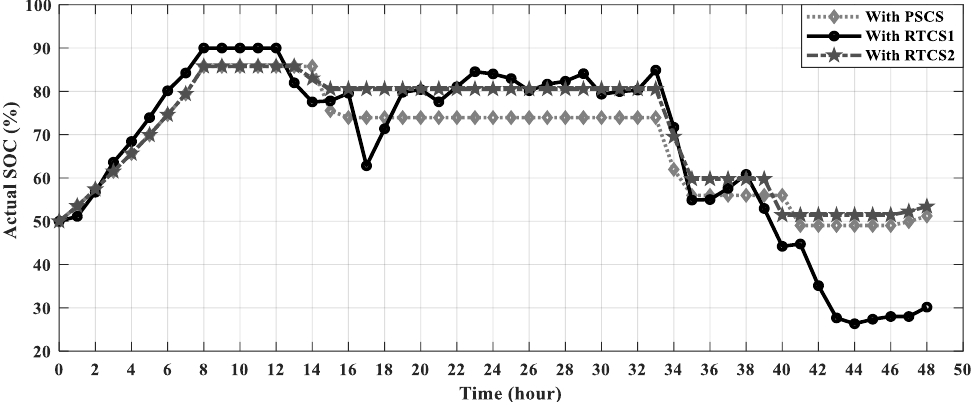
Figure 8. Actual state of charge (SOC) profile with different BESS control schemes.